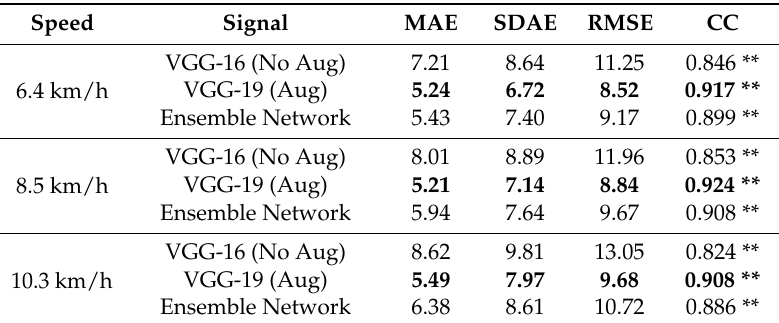
Table 5. Estimation of heart rate for running by CNNs.